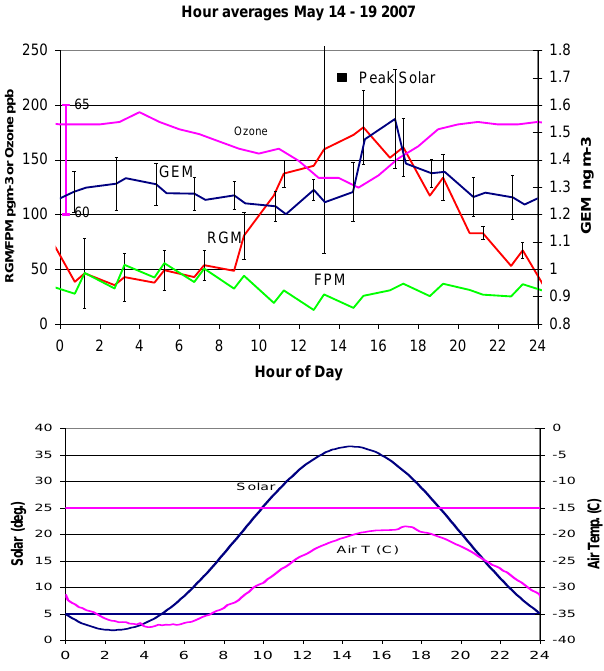
Fig. 5. Diurnal hourly averages of RGM, GEM, FPM and ozone at Summit, 14–19 May 2007. Daily RGM peaks with maximum solar elevation. RGM and GEM are shown with standard deviation bars. Solar elevation and air temperature are shown with our modeled thresholds of 5 degree solar elevation and − 15 ◦ C.